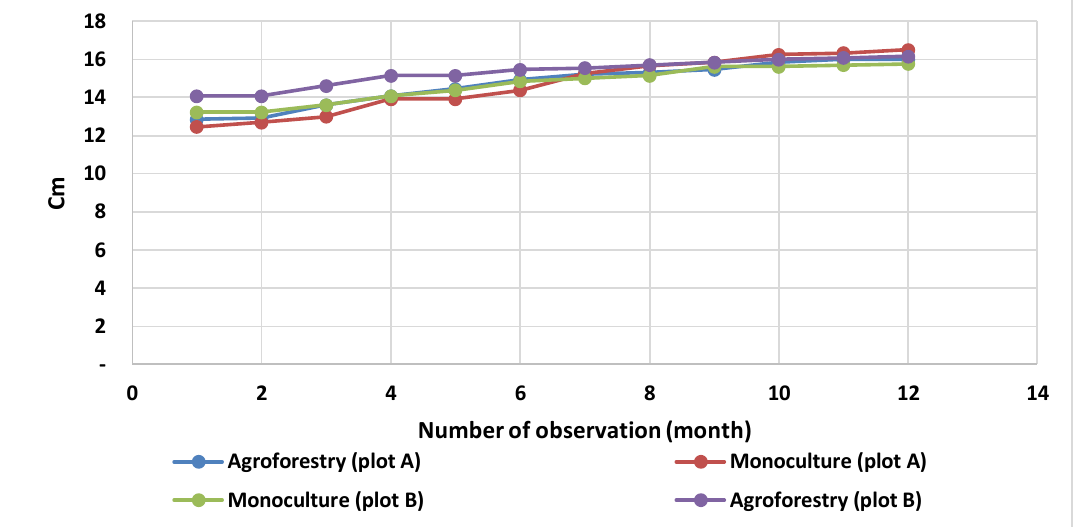
Figure 7. Circular stem growth of nyamplung in monoculture vs. agroforestry plots in Buntoi reseaech site in Central Kalimantan.